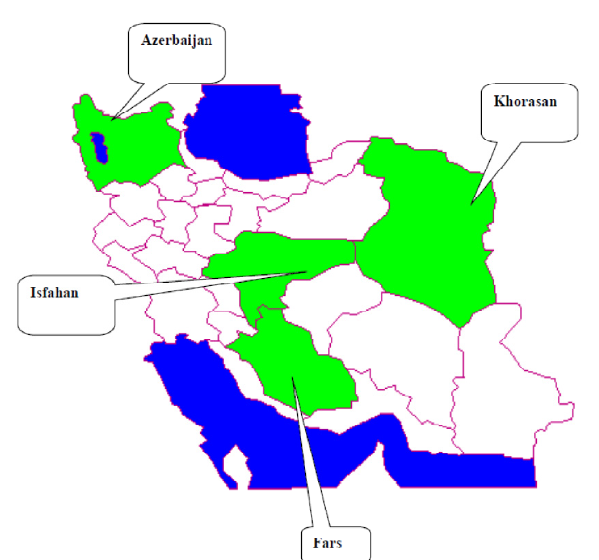
Fig. 1. Study regions in Iran